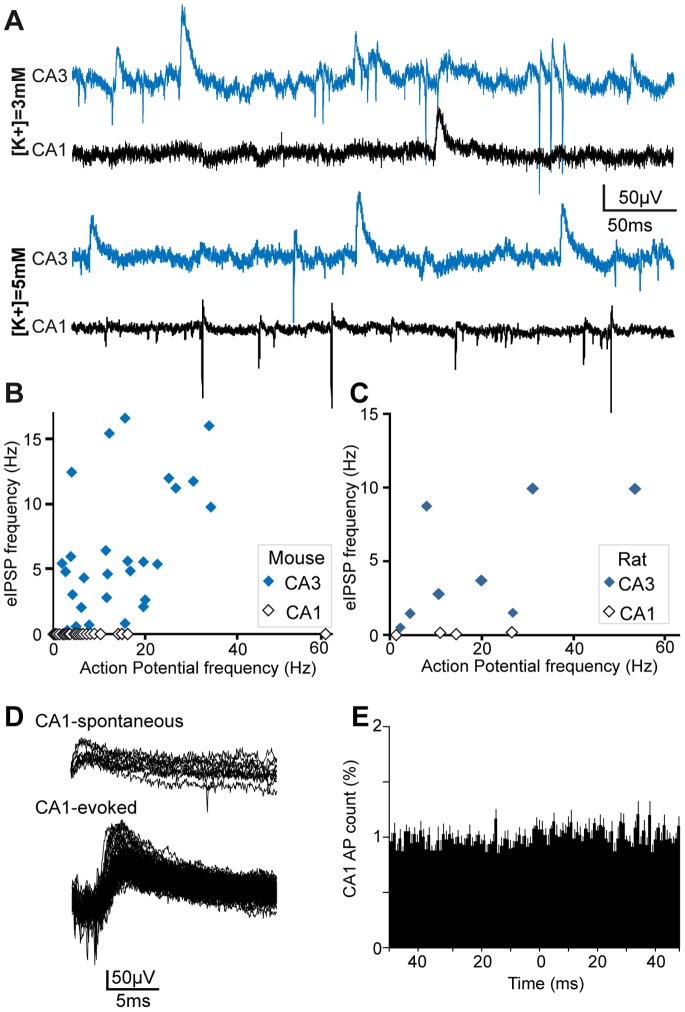
Spontaneous eIPSPs are rare events in CA1.A. Simultaneous recording of spontaneous activity in the CA3 and CA1 regions of a mouse in control (top traces, K+3 mM) and high K+ (lower traces, K+5 mM). The upper CA1 trace was specifically selected to illustrate a CA1 eIPSP, which were very rare events in CA1, even in presence of high-K+ induced intense multi-unit activity (lower CA1 trace). B–C. Relationship between multi-unit activity and eIPSP frequency (B, mice, n = 6; C, rats, n = 3), measured in CA3 (blue diamonds) and CA1 (white diamonds) simultaneously, in presence of various extracellular K+ concentrations (range 3–8 mM). Note that eIPSP frequency in CA1 remains low whatever the frequency of multi-unit activity. D. Superimposed traces of rat CA1 eIPSPs that either occured spontaneously (CA1-spontaneous, upper traces) or were evoked by minimal extracellular electrical stimulation close to the CA1 pyramidal layer (CA1-evoked, lower traces). E. Crosscorrelogram between CA1-MUA and CA3-eIPSPs (rats, n = 3).